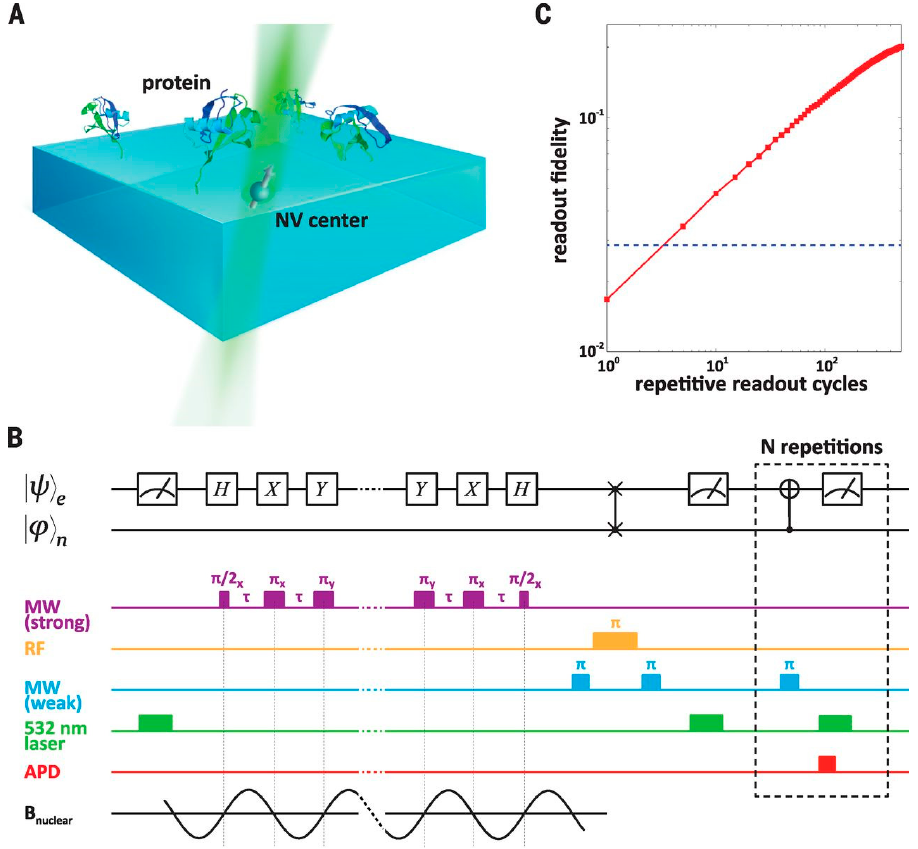
Figure 1. Experimental setup and magnetometry with repetitive readout described in [11]. Image from [11]. Reprinted with permission from AAAS. ( A ) Schematic of the experimental setup. Ubiquitin proteins attached to the diamond surface are probed using a proximal quantum sensor consisting of a nitrogen-vacancy (NV) center electronic spin and its associated 15 N nuclear spin; ( B ) Quantum circuit diagram and experimental magnetometry pulse sequence; ( C ) Measured gain in the readout fidelity as a function of repetitive readout cycles. MW: microwave; RF: radiofrequency; APD: avalanche photodiode; B magnetic field of the nuclear spin.